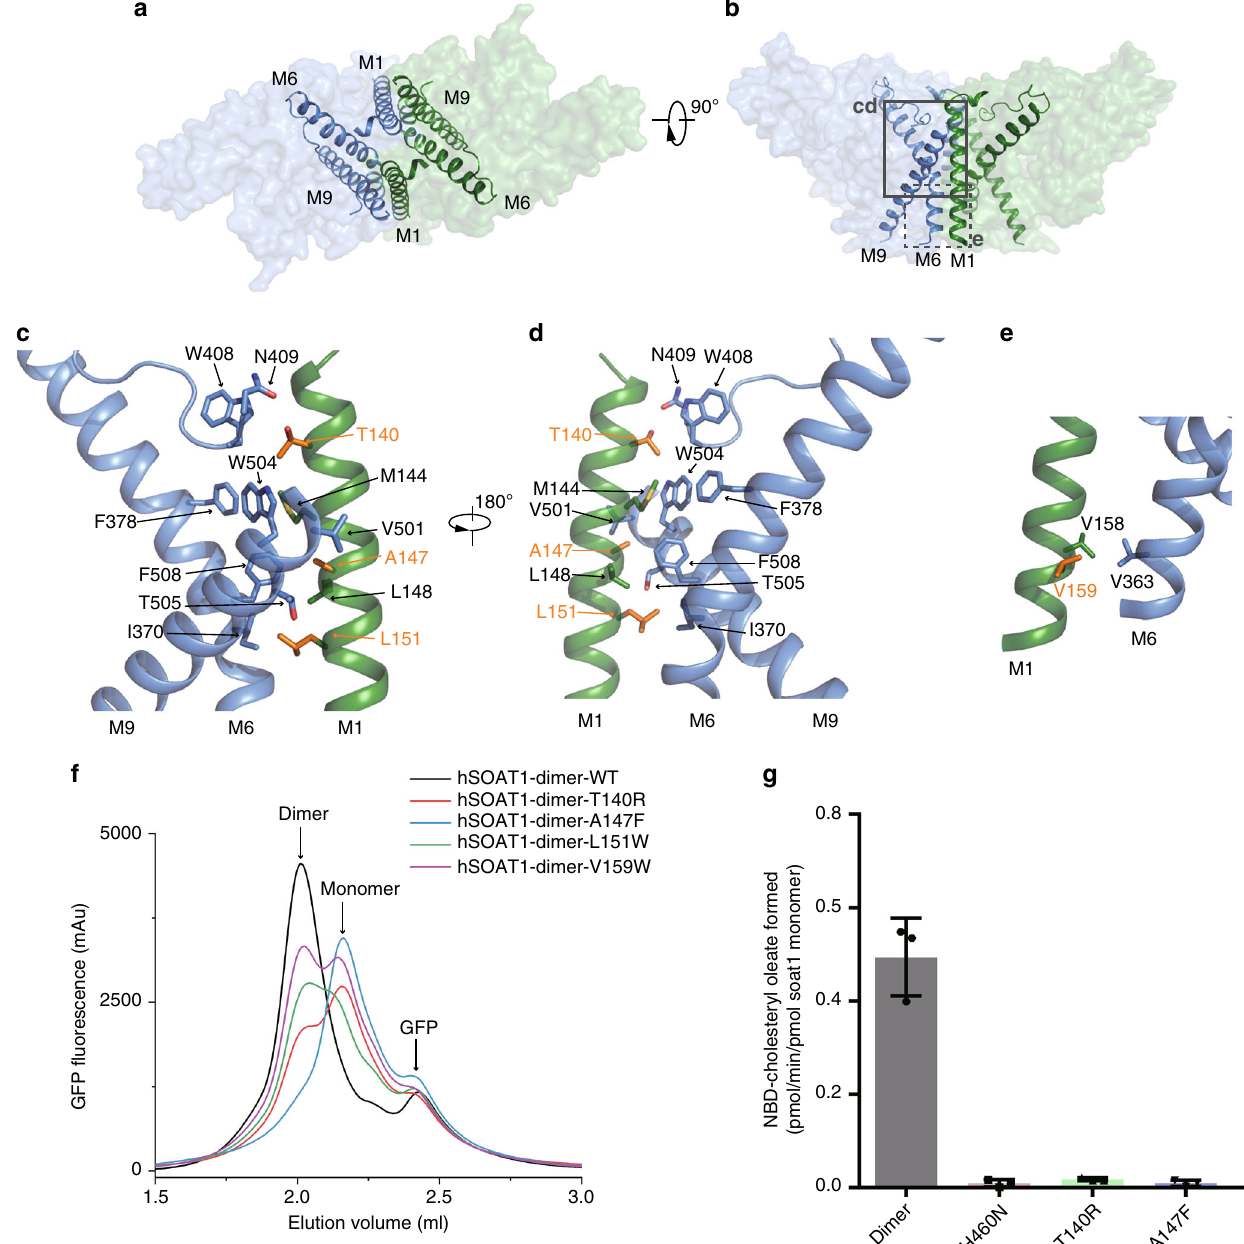
Fig. 4 The dimer interface of hSOAT1 dimer. a, b Top view and side view of one hSOAT1 dimer are shown in surface representation with semi- transparency. M1, M6 and M9 helices are shown as ribbons. c Close-up view of the dimer interface boxed by solid lines in b . Interacting residues were shown in sticks. Residues mutated in f were shown in orange. d A 180° rotated view compared to c . e Close-up view of the interacting residues boxed by dashed lines in b . f FSEC traces of hSOAT1 dimer with interface mutations. g The activities of hSOAT1 dimer mutants measured using NBD-cholesterol as substrate, in the presence of cholesterol. Source data are provided as a Source Data fi le (Data are shown as means ± standard deviations, n = 3 biologically independent